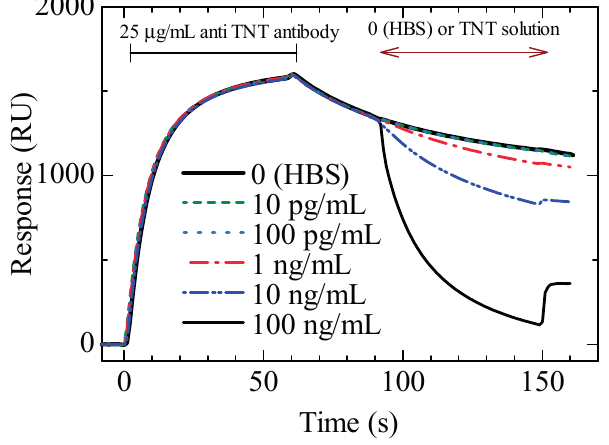
Figure 10. Sensorgrams of displacement immunosensor using 25 μ g/mL TNT–Ab to detect varying concentrations of TNT on DNP–gly-modified sensor chip